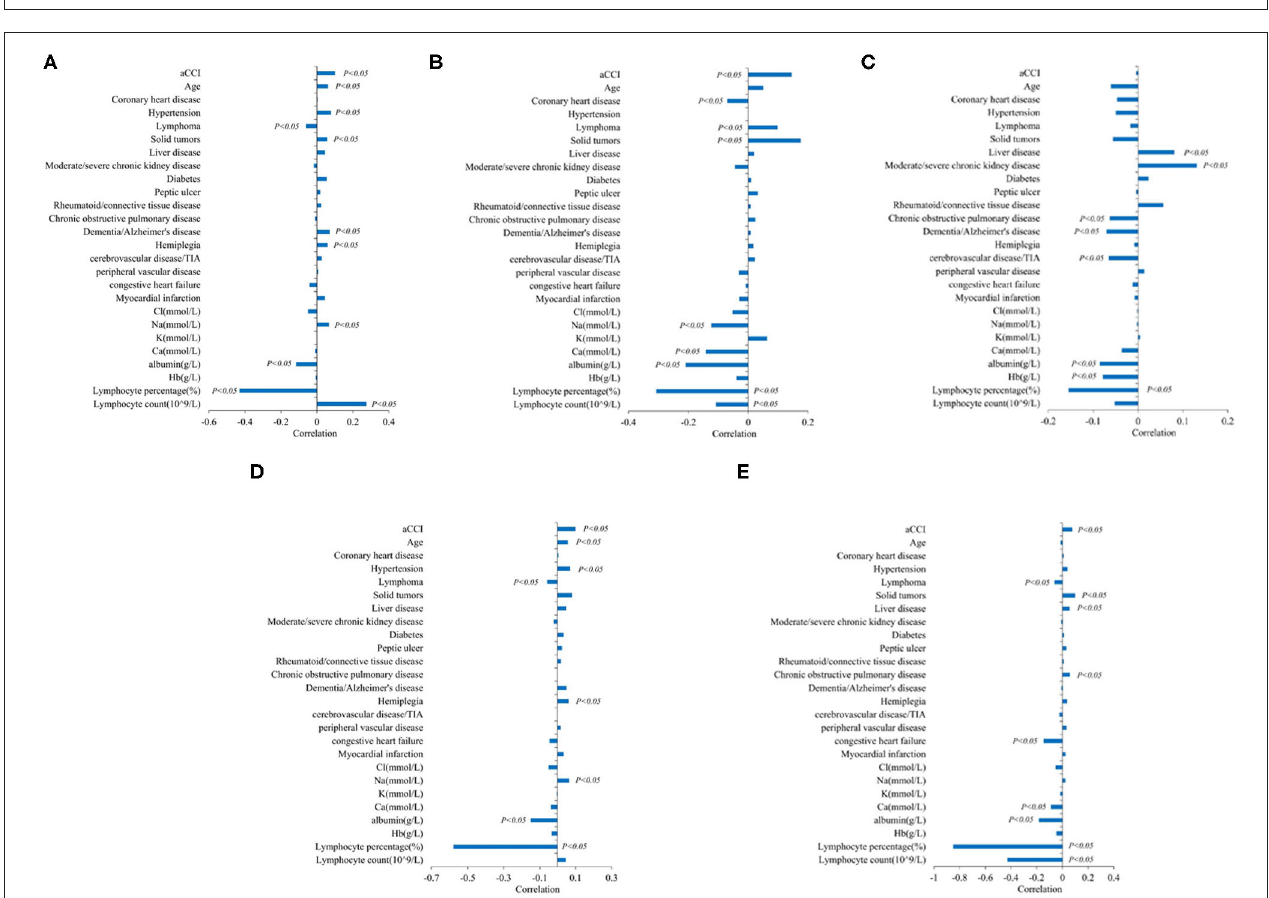
FIGURE 2 | Heat map of correlation analysis. (A) Associations between nutritional status, infection levels and pneumonia in all infected patients. (B) Associations between nutritional status, infection levels and pneumonia in HAP. (C) Associations between nutritional status, infection levels and pneumonia in CAP.